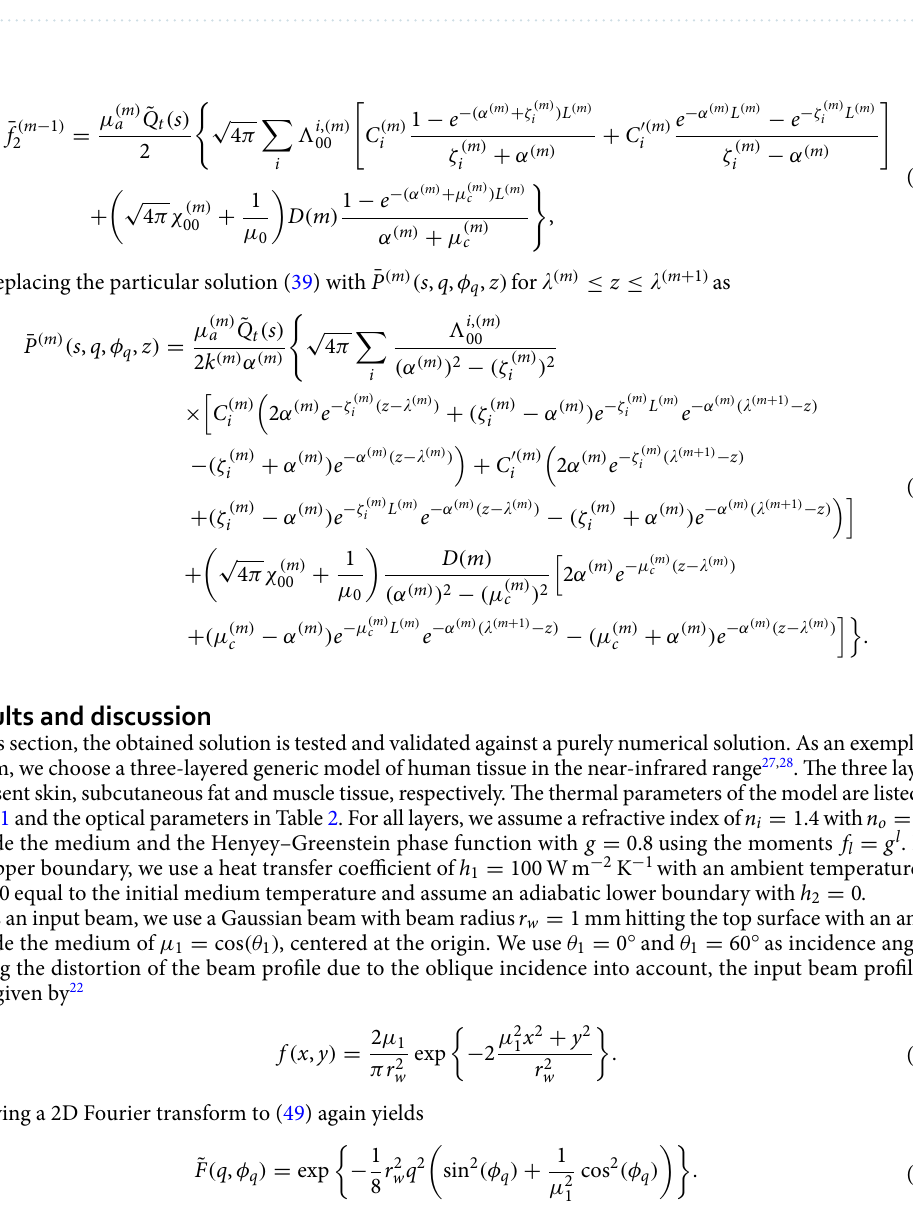
Table 2. Optical parameters of the considered medium. For the phase function, the Henyey–Greenstein function is used. The refractive index n i must be identical for all layers, while the refractive index outside the medium is set to